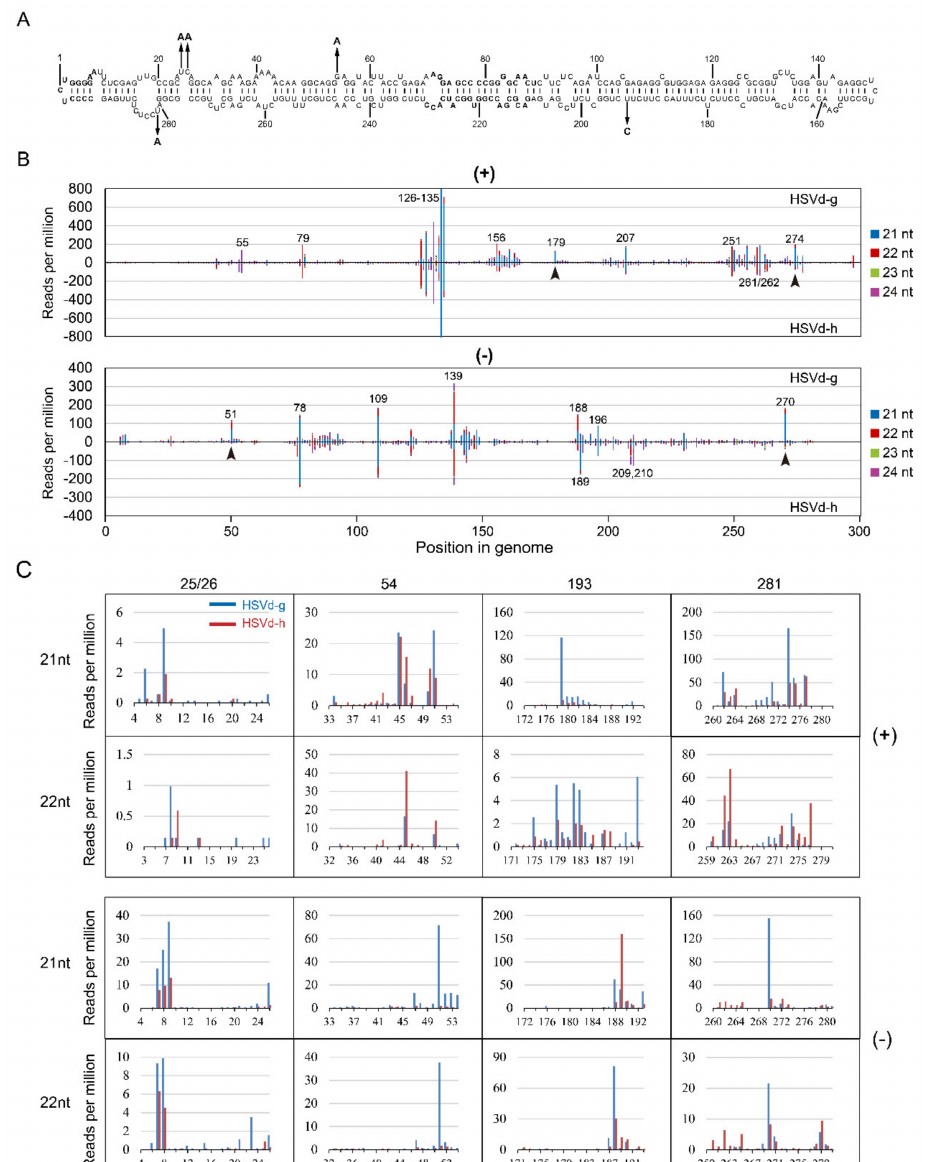
Figure 7. Sequence profiles of HSVd-sRNA derived from the genomic ( + ) and anti-genomic ( − )-strands of HSVd-g or HSVd-h in cucumbers. The top panel ( A ) shows the predicted secondary structure of HSVd-g. The five hop-adaptive mutations between HSVd-g and HSVd-h are indicated by the arrows. sRNA distribution profiles shown in panel ( B ) represent the sum of 21–24-nt HSVd-sRNA populations recovered from cucumber plants infected with HSVd-h or HSVd-g plotted along the linearized HSVd genome (nucleotides 1–297 from left to right). sRNA distribution profiles of HSVd-g and HSVd-h are compared for genomic (upper panel) and anti-genomic (lower panel) strands. Genome positions of selected hot-spot peaks are marked by corresponding numbers. Arrowheads indicate sRNAs containing adaptive mutations that distinguish HSVd-g from HSVd-h and accumulate to obviously di ff erent levels. Details of their amounts and sequences are shown in panel ( C